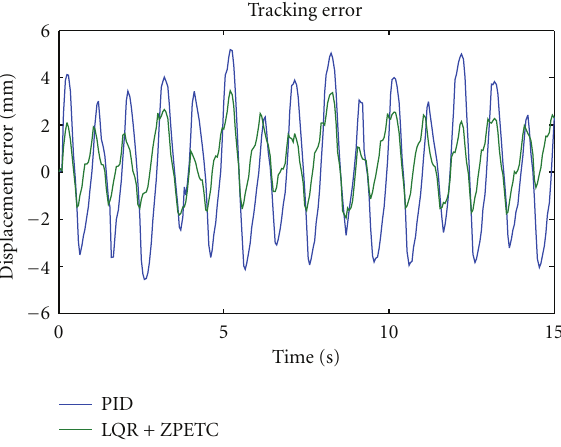
Figure 9: Simulation and experimental results of 30 mm reference trajectory.